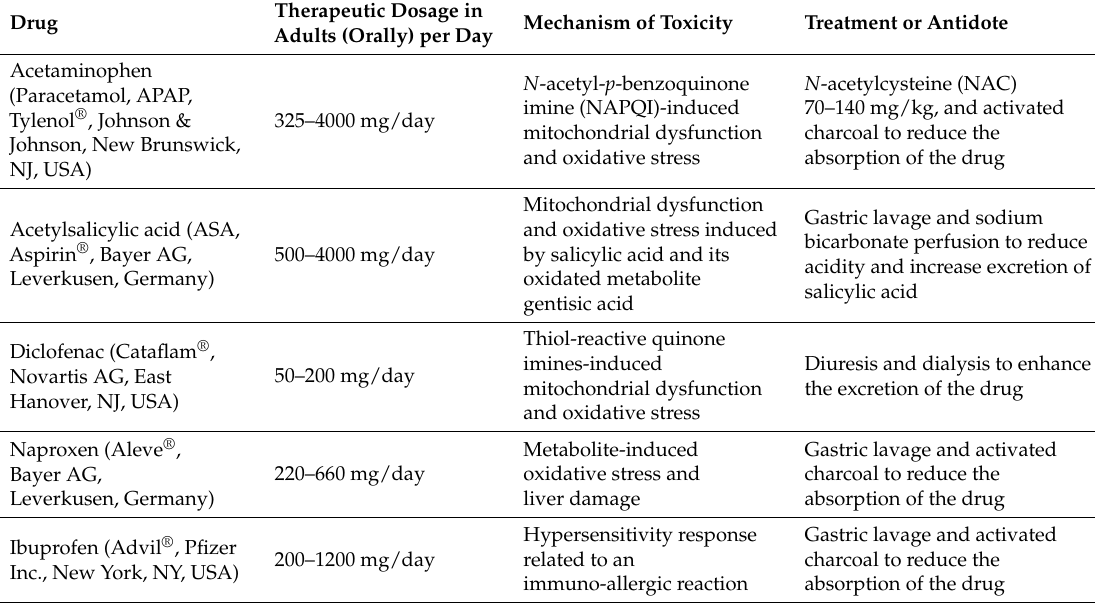
Table 1. Range of therapeutic dosage per day of acetaminophen and non-steroidal anti-inflammatory drugs (NSAIDs) in humans and current treatments against